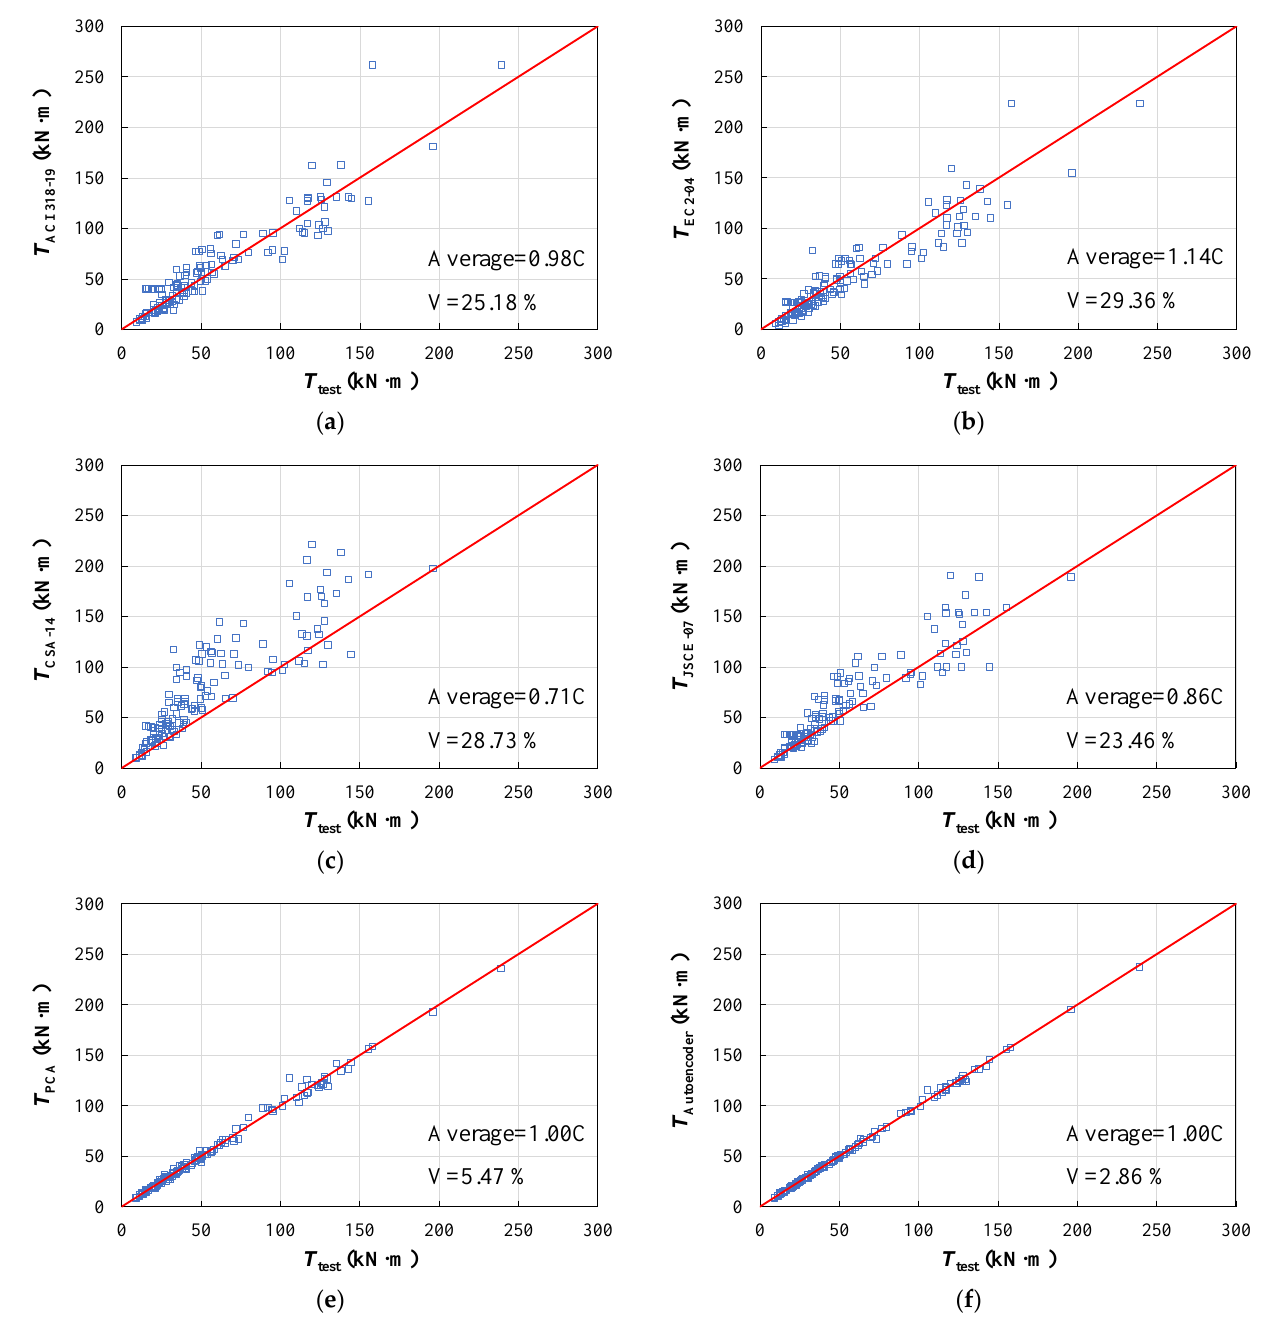
Figure 3. Comparisons between predicted and measured torsional strength of the training dataset. ( a ) ACI 318-19; ( b ) EC2-04; ( c ) CSA-14; ( d ) JSCE-07; ( e ) PCA; ( f ) autoencoder.